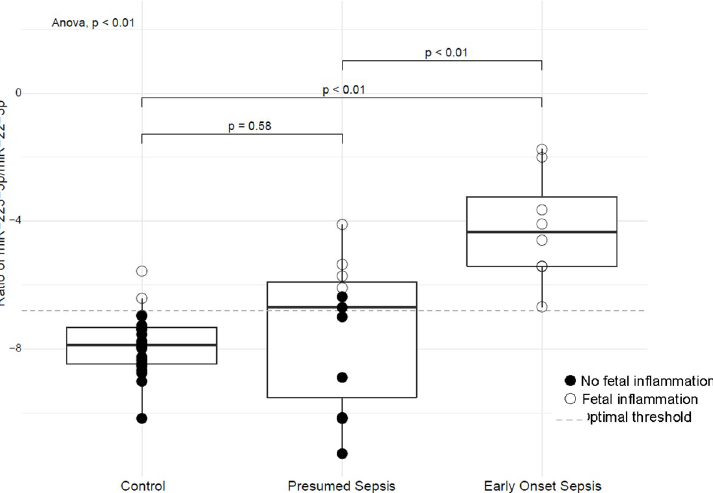
Fig 2. Ratio of miR-223-5p/miR22-3p in FFPE umbilical cord tissue. This graph depicts the median, interquartile range, and outliers for the three study groups: non-infected controls, presumed sepsis, and EOS. The ratio is significantly higher in EOS than non-infected controls. The ratio is intermediate in presumed sepsis.